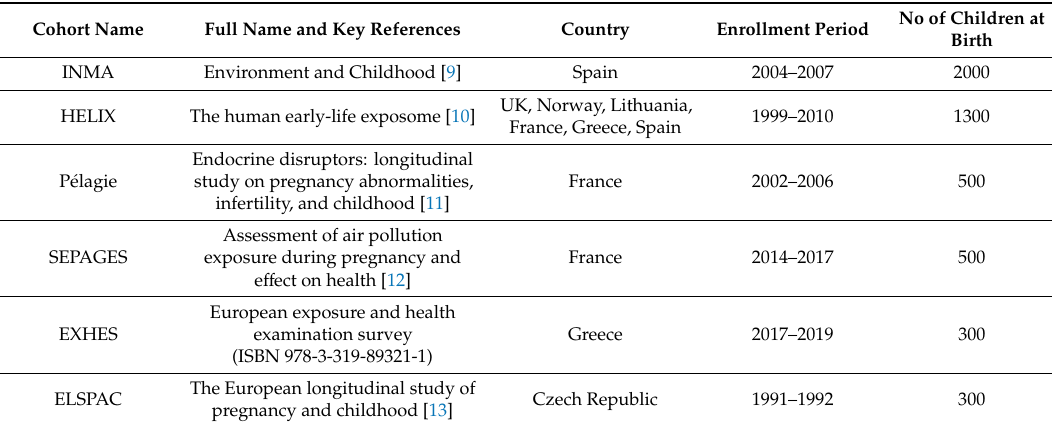
Table 2. List of the human cohorts used in